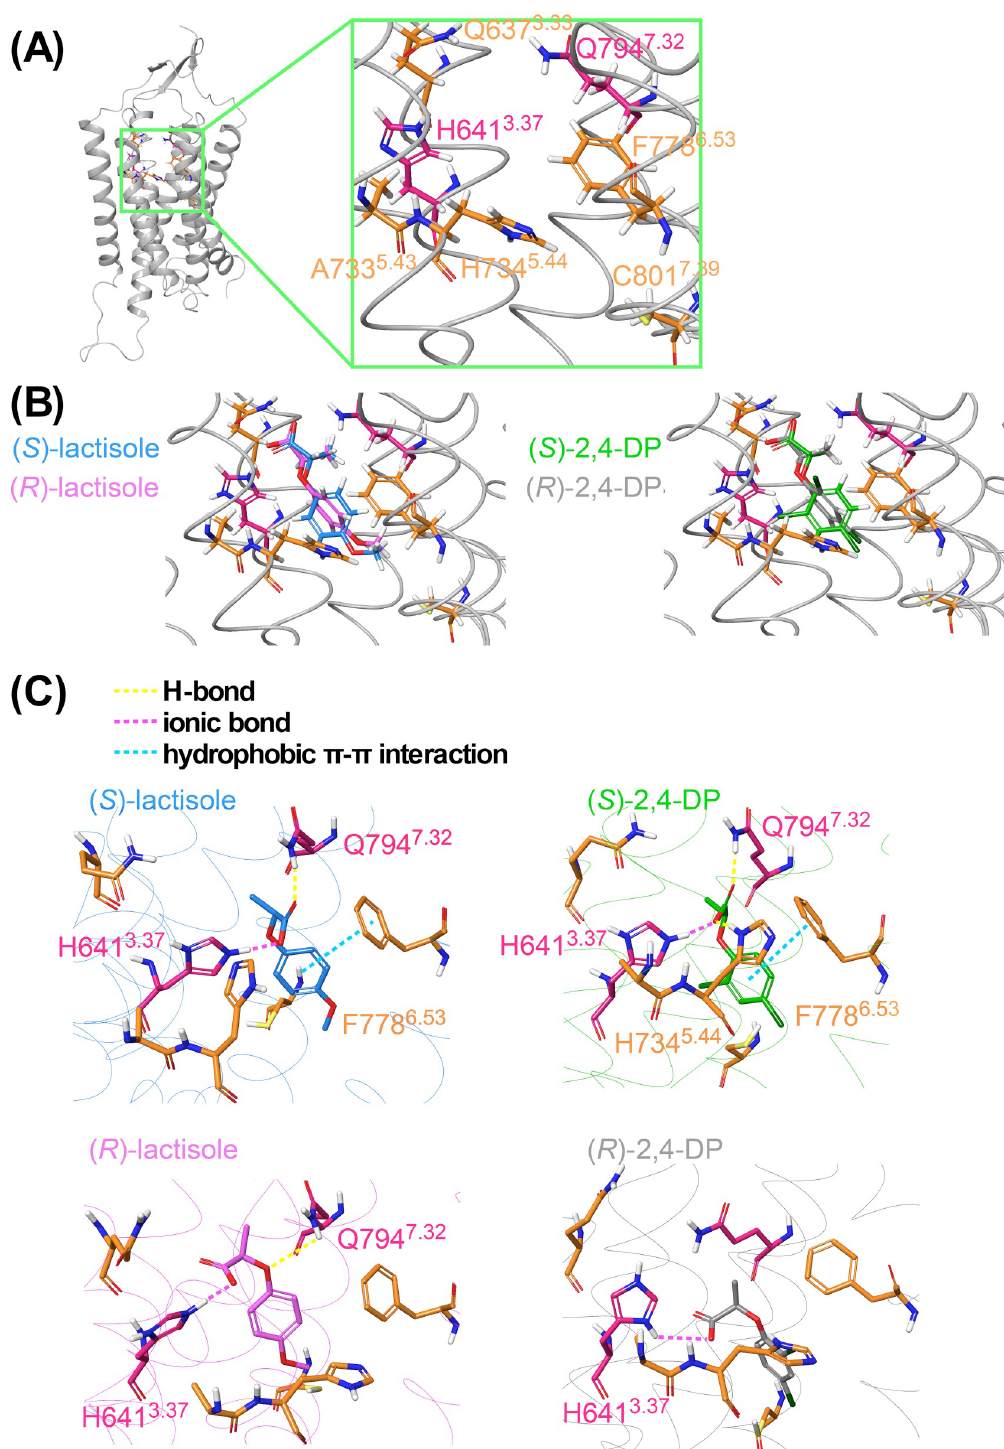
Fig 2. MD Simulations and their pre-simulations for lactisole and 2,4-DP. (A) T1R3-TMD homology model created based on mGluR1 TMD (PDB ID: 4OR2). An enlarged view of the candidate ligand pocket is shown in the right window. Residues extracted by cellular analyses are indicated by colored stick illustrations. (B) Docking modes of ( S )-lactisole (shown in blue) and ( R )-lactisole (shown in pink) are shown in the left figure. ( S )-2,4-DP (green) and ( R )-2,4-DP (gray) are shown on the right. (C) MD minimizations (100 ns) were performed for each ligand from the docking models. The two left panels show the results for isomers of lactisole (upper panel: ( S )-lactisole and lower panel: ( R )-lactisole). The two right panels show the